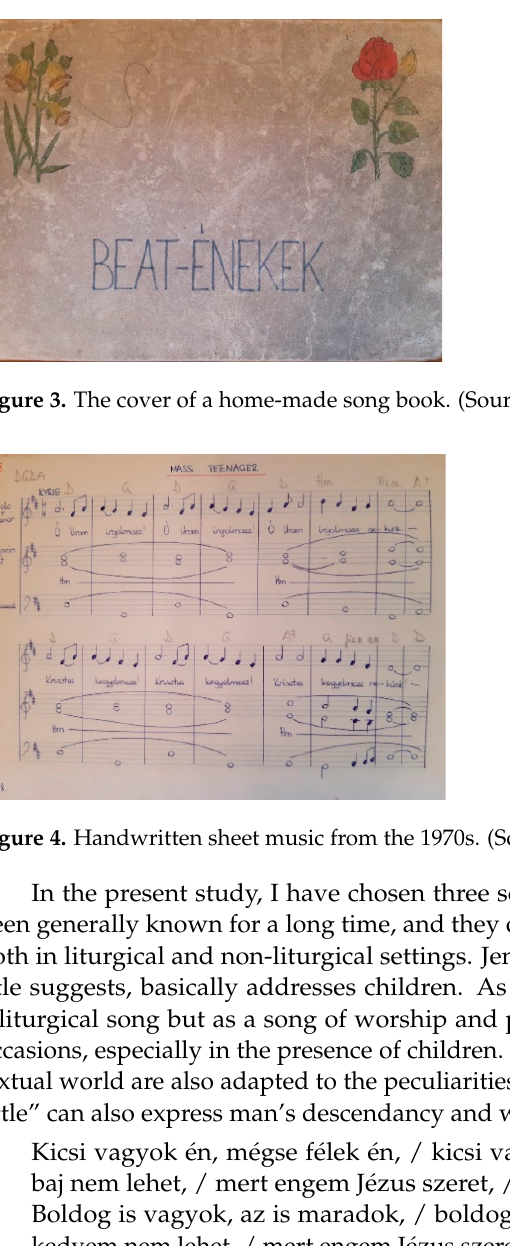
Religions 2021 , 12 , x FOR PEER REVIEW